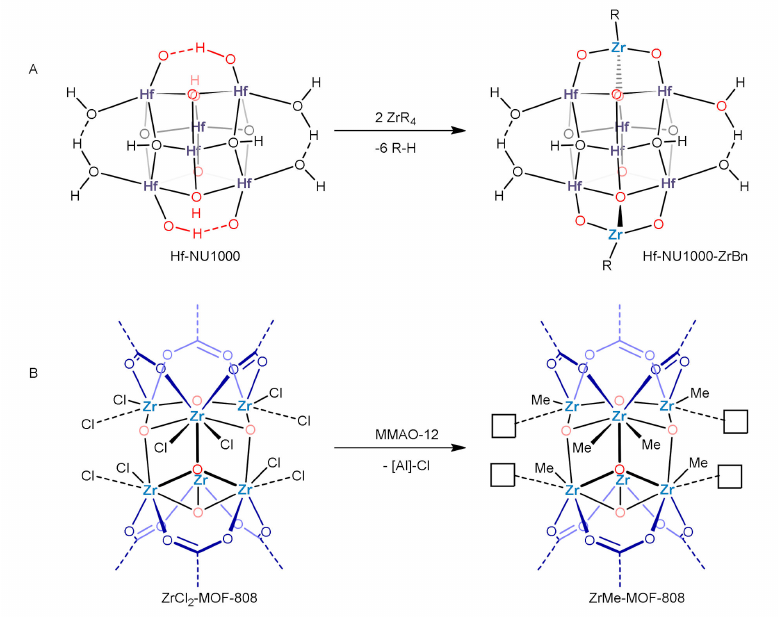
Figure 2. ( A ) Synthesis and structure of Hf-NU1000-ZrBn catalyst. ( B ) Synthesis and structure of ZrMe-BTC catalyst. Blank square indicates open coordination around